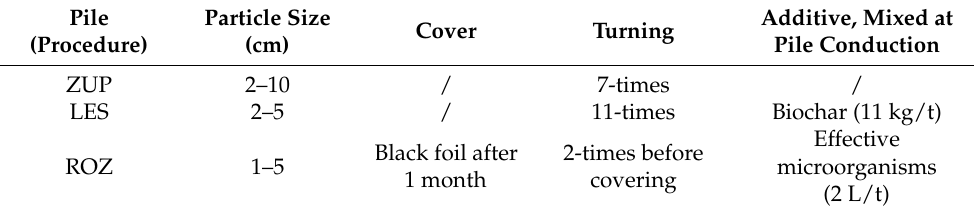
Figure 1. Metal drip tray setting. Table 1. Biomass properties and treatment